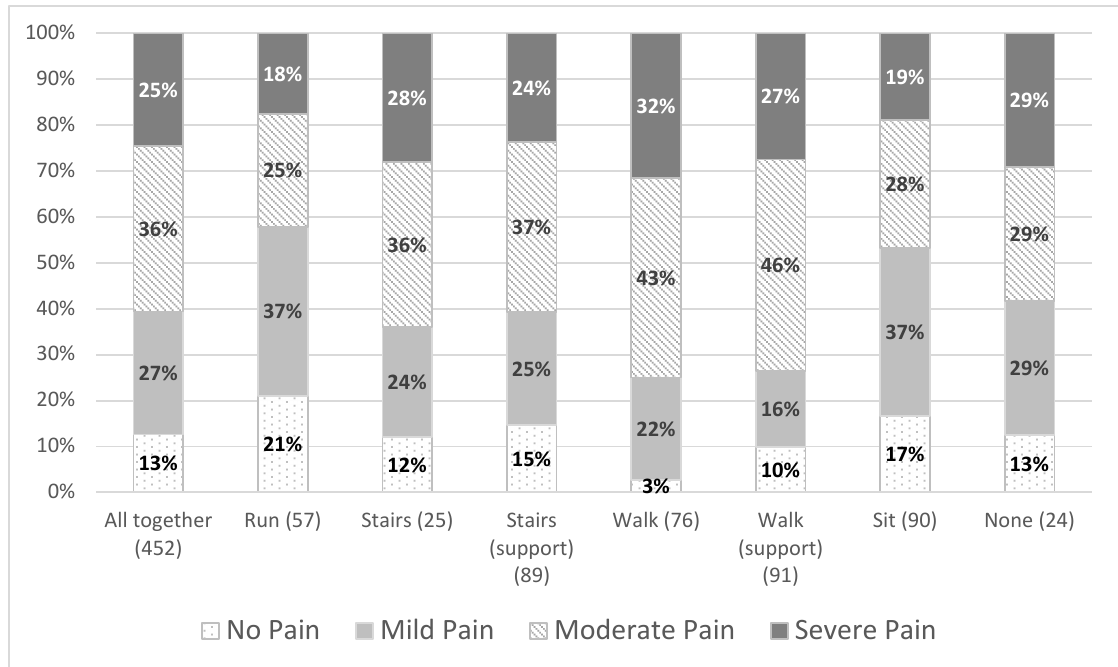
Figure 3. Severity of pain by ambulatory status.